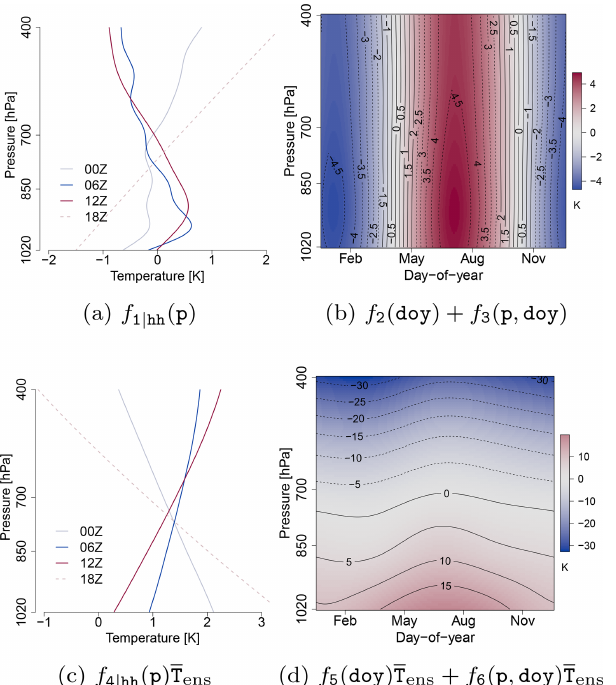
Figure 1. Example of the effects of the location parameter µ (Eq. 2) of the NGRVC model for station Bergen. (a) and (b) are the terms of the varying intercept and (c) and (d) the terms of the vary- ing coefficient in Eq. 2 multiplied by T ens . They are computed for the average profiles of T ens by p only (a, c) and p , doy and hh = 12:00UTC (b, d) , respectively, and the average of SD ens :